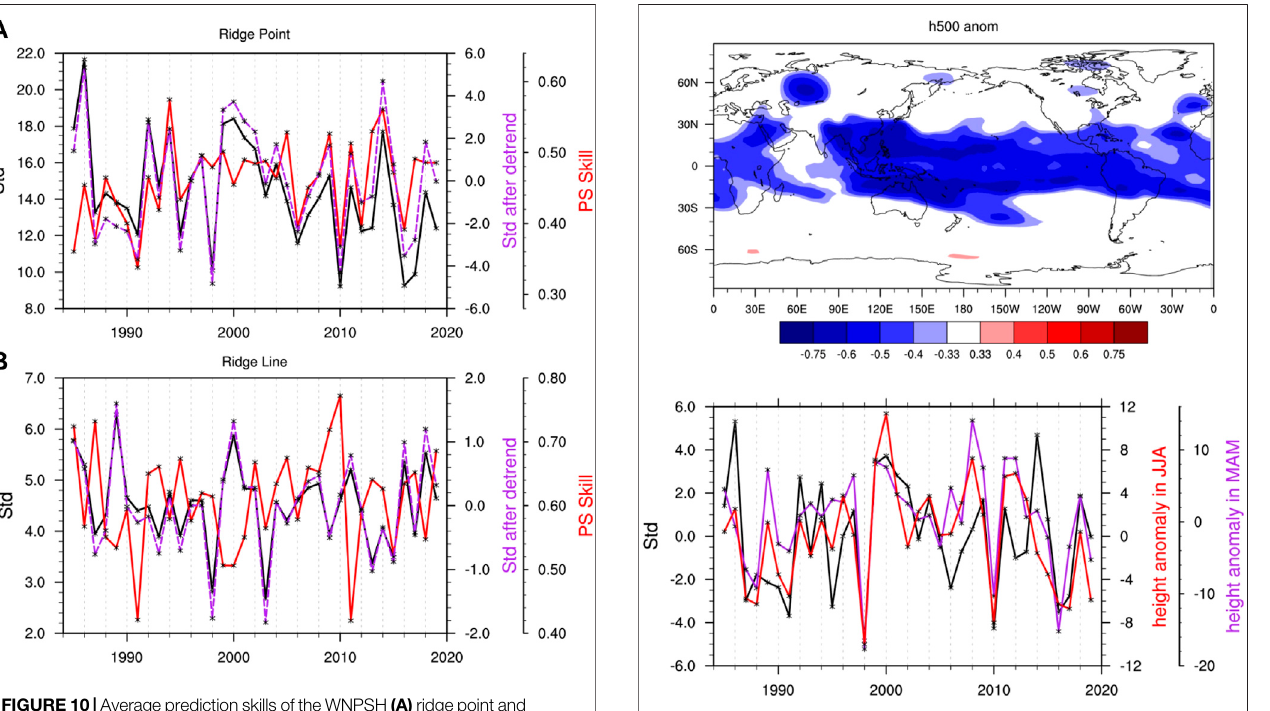
FIGURE 11 | (A) Correlation coef fi cients between the detrended 500- hPa height anomaly and the ridge point prediction skills in Figure 10A , only show the values passing the 95% con fi dence t -test. (B) Standard deviations oftheWNPSHridgepointindex(blackline),the500-hPaheightanomaly indices during summer (red line) and spring (purple line) averaged over the tropical region (30 ° S – 30 ° N, 0 – 360 ° E). Here, the height anomalies have been multiplied by